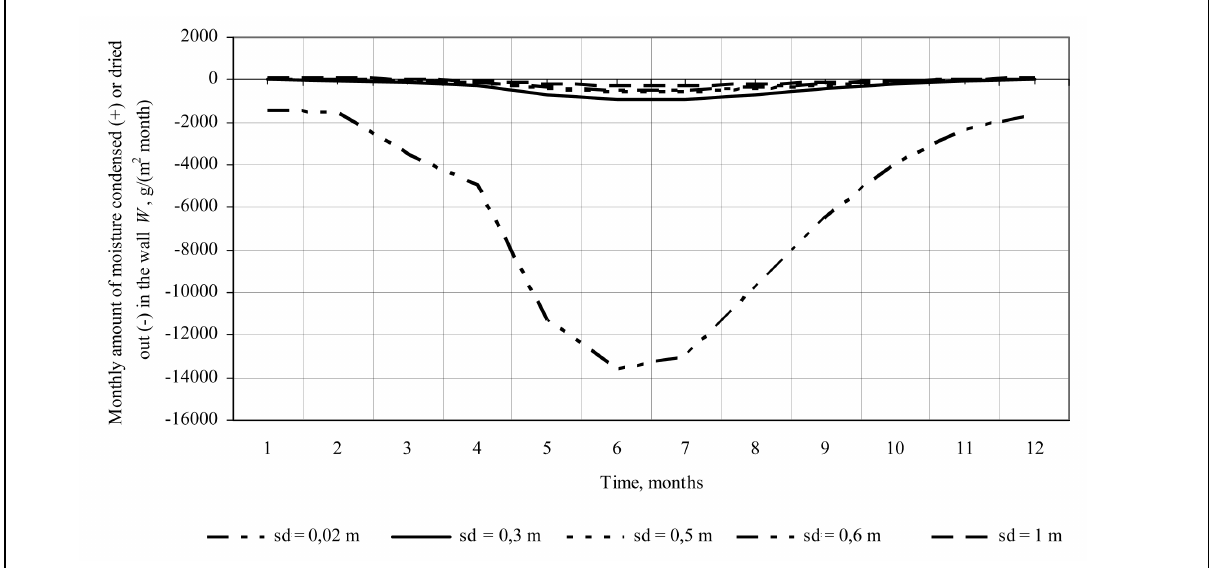
Fig 8. Annual dynamics of moisture alteration in the wall in its possible zone of condensation when the thickness of the air layer equivalent to the material’s water vapour permeability s d